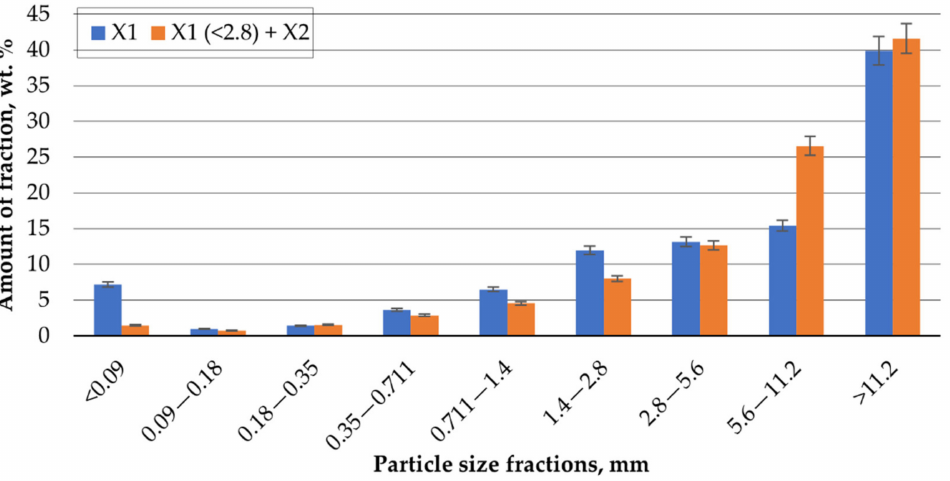
Figure 7. Particle size distribution of the disintegration–milled PCBs after first “X1” and second milling of the fraction with particle sizes larger than 2.8 mm from first milling designated as “X1 (>2.8) +